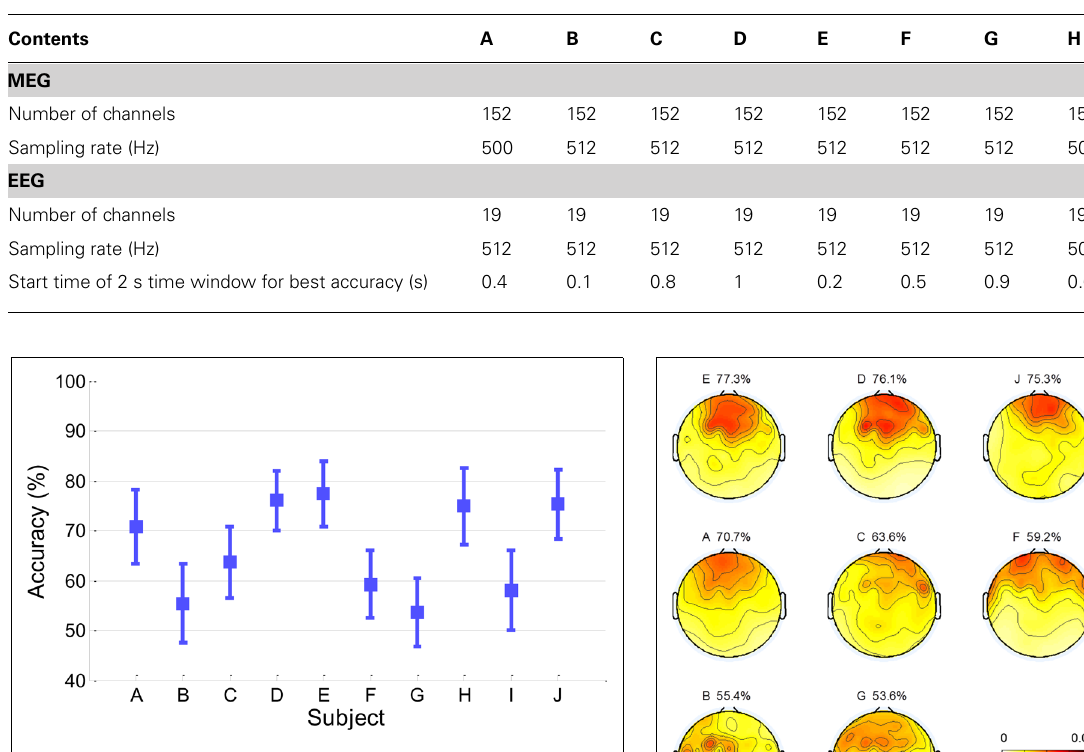
Table 1 | Experimental information.